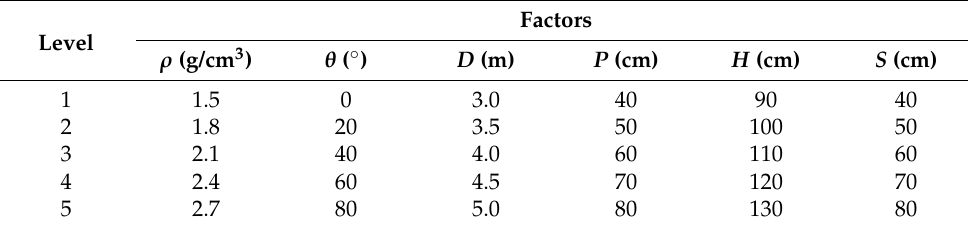
Table 5. The influencing factors and level of the massive structure rock mass.